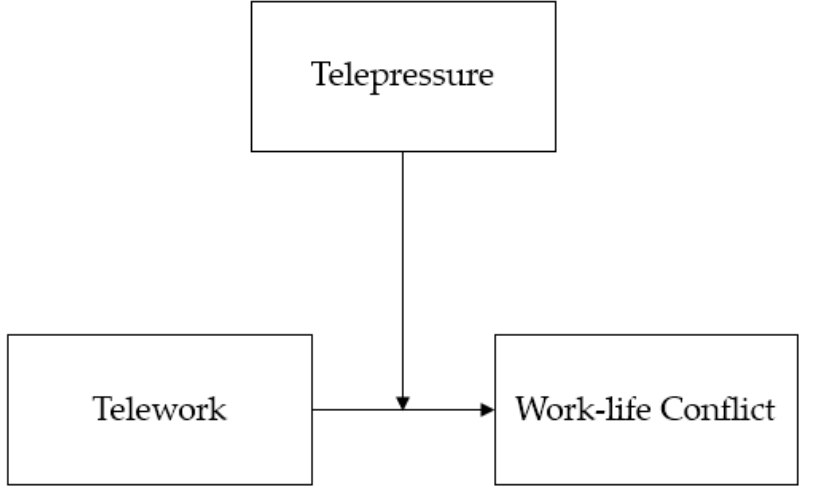
Figure 1. Research Model. Note . Within-person level interaction effect was estimated. Hypothesis 4. Telepressure will moderate the relationship between telework and work–life conflict. Specifically, a negative ( − ) relationship will be reported for those with low telepressure, but not for those with high